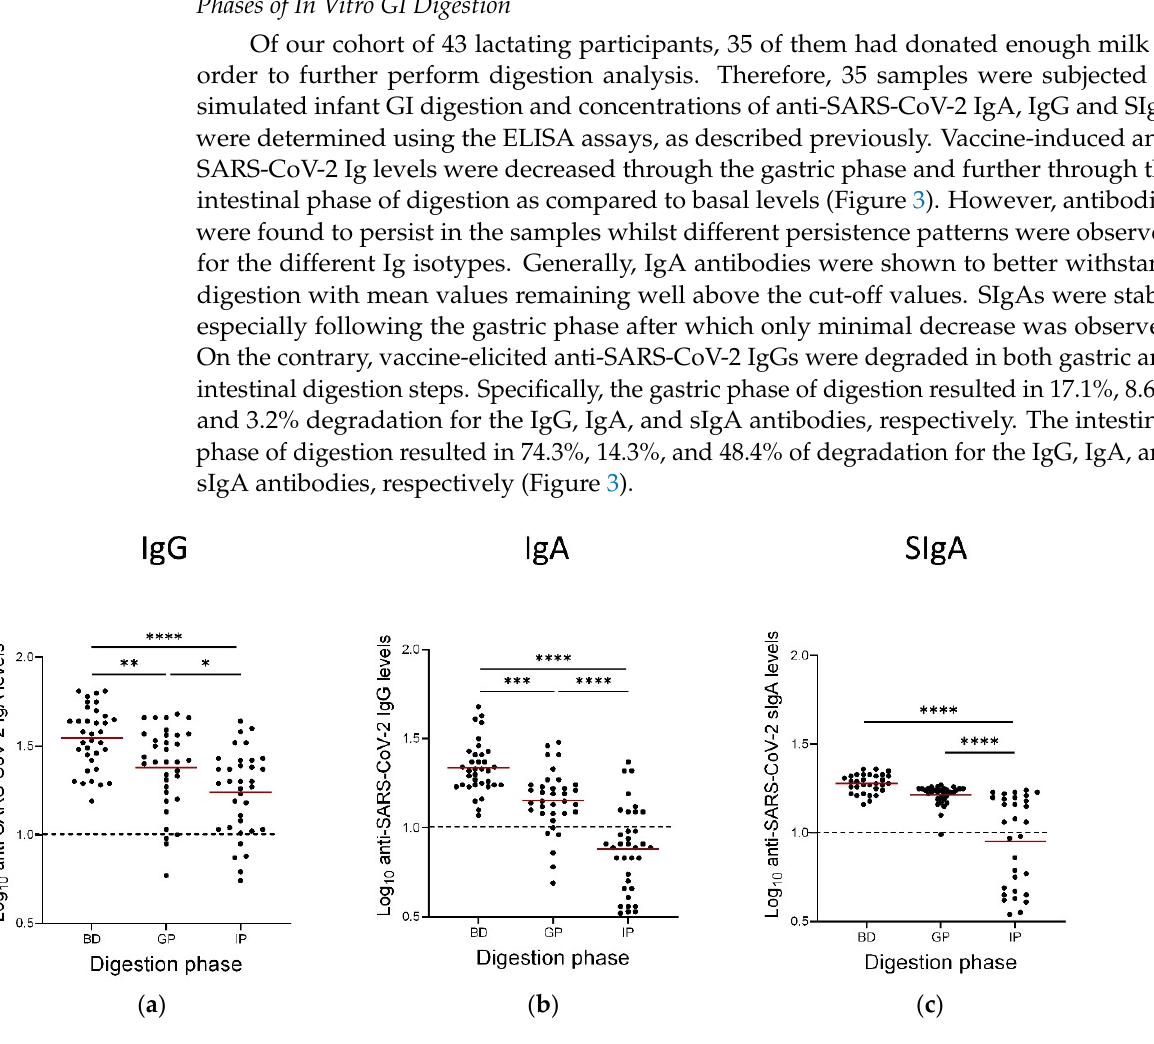
Figure 3. Concentrations of IgG ( a ), IgA ( b ), and Secretory IgA (SIgA) SARS-CoV-2 antibodies ( c ) in milk before and after a 1 h simulated gastric digestion and a 2 h simulated intestinal infant digestion protocol. Dotted lines: positive cut-off values previously determined for each assay as the mean values of negative control (before vaccination) milk samples. Asterisks show statistically significant differences between variables (* p < 0.05; ** p < 0.01; *** p < 0.001, **** p < 0.0001) using one-way ANOVA followed by Tukey’s multiple comparisons test. BD: before digestion, this sample was taken 3 weeks after the second vaccine dose, GP: After the Gastric phase of digestion, IP: after the intestinal phase of digestion. Horizontal bars indicate mean values.